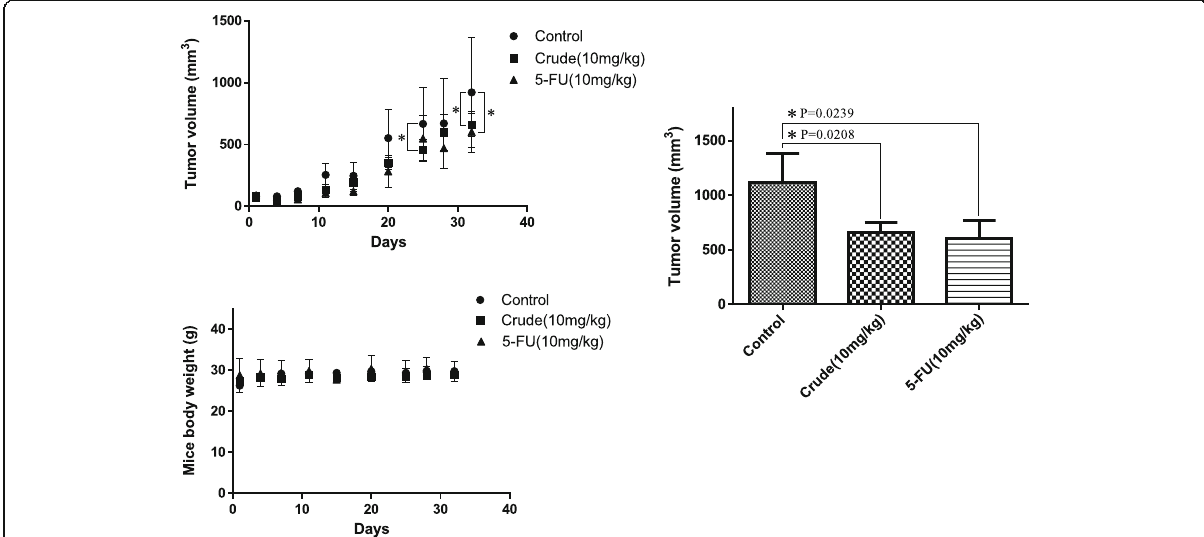
Fig. 5 Repression of tumor cell growth in SAS xenograft mice via the Danshen crude. The Danshen extract inhibited oral cancer cell growth in vivo. The SAS xenograft was exposed to either saline (control) or the Danshen extract (crude, 10 mg/kg), and 5-FU (10 mg/kg) served as the positive control